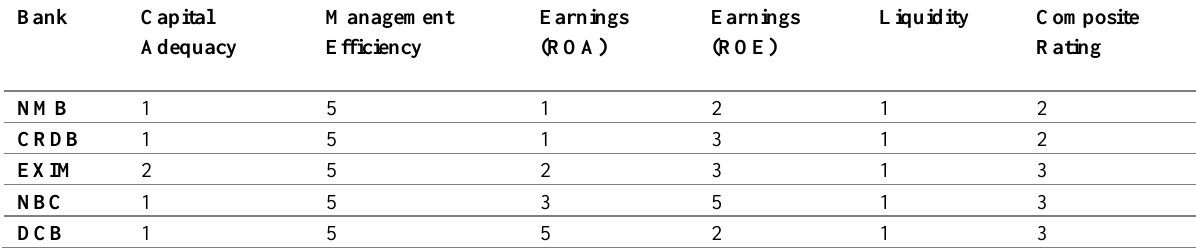
Table 8: CAMEL Composite Rating Before and After